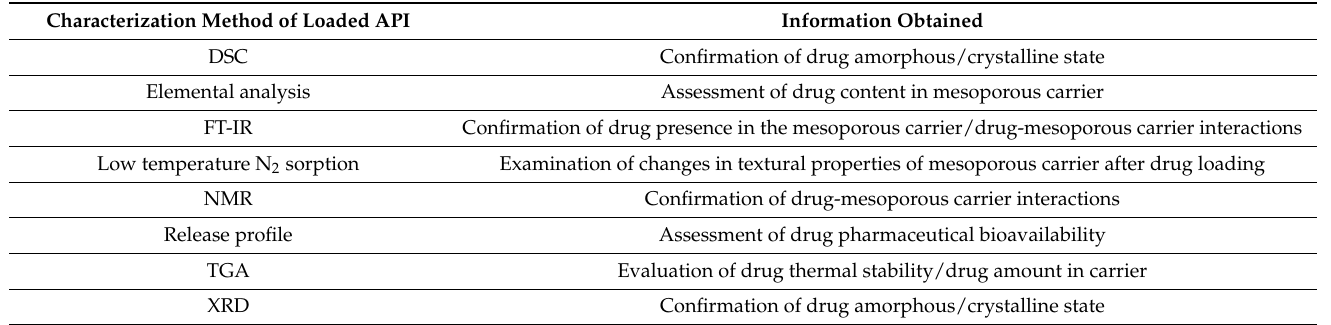
Table 4. Methods used for analysis of drugs loaded in mesoporous siliceous